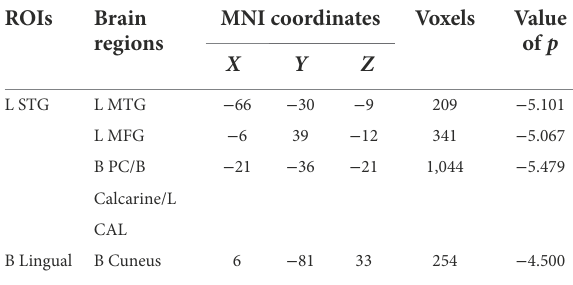
TABLE 3 Functional connectivity between ROIs and the whole brain.